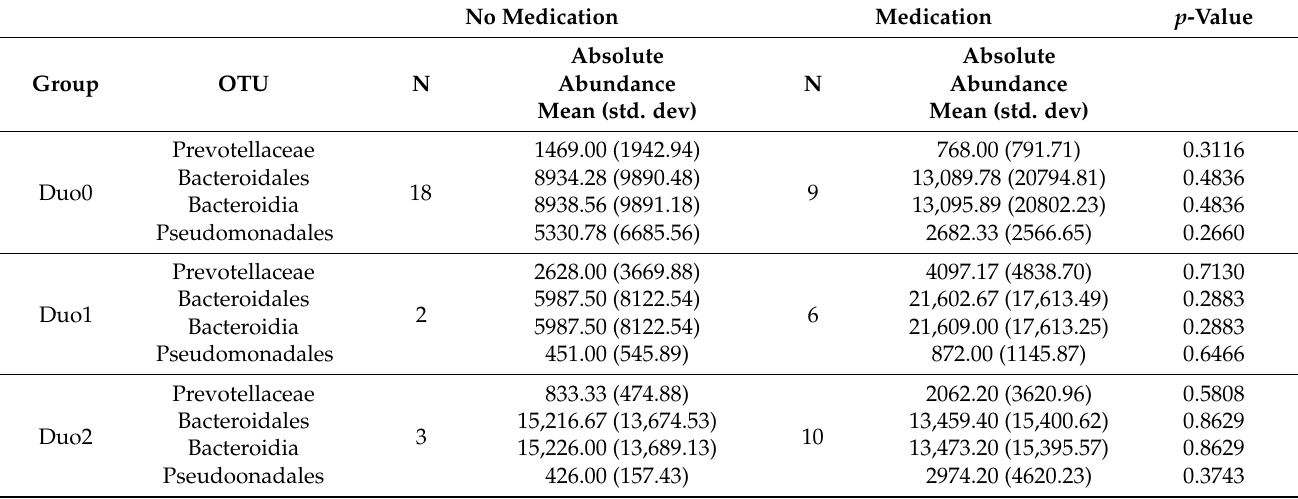
Table 3. Descriptive statistics for the TI sample population comprised of three study groups: Control